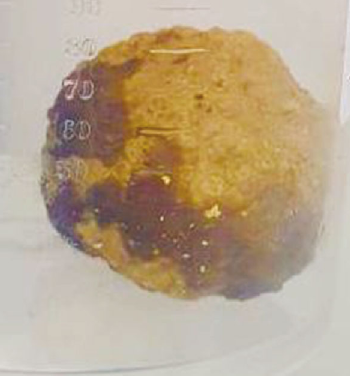
Figure 2: Stone extracted from the small bowel (1.8